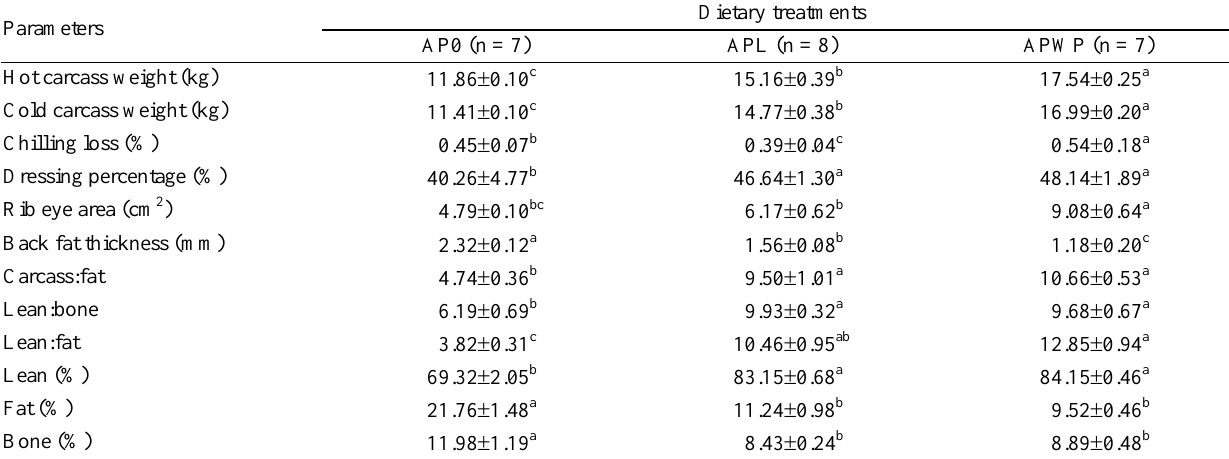
Table 3. Carcass characteristics of goats fed diets containing Andrographis paniculata Parameters